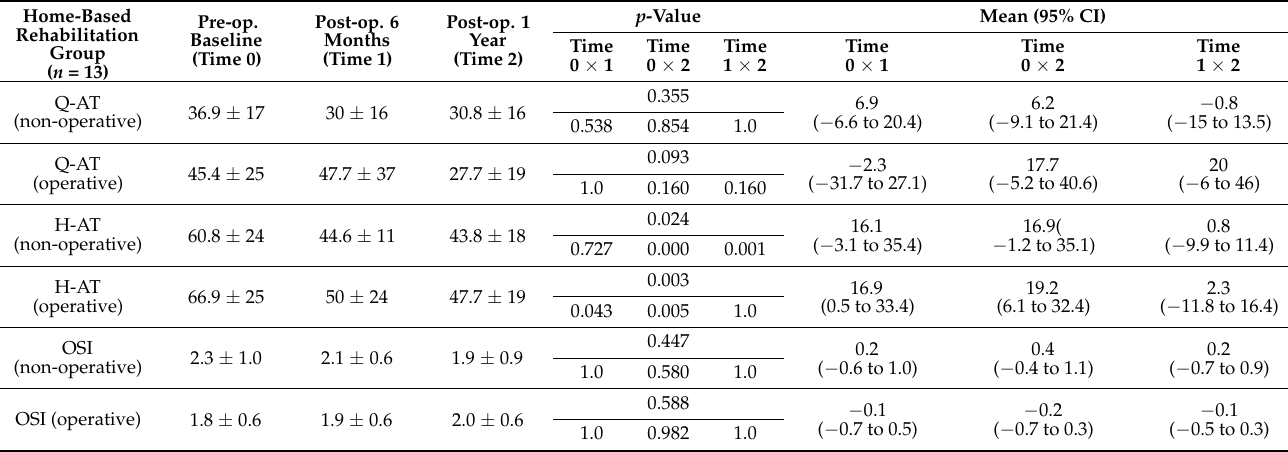
Table 5. Serial changes in acceleration time of quadriceps and hamstring, and dynamic postural stability of enrolled subjects in the home-based rehabilitation